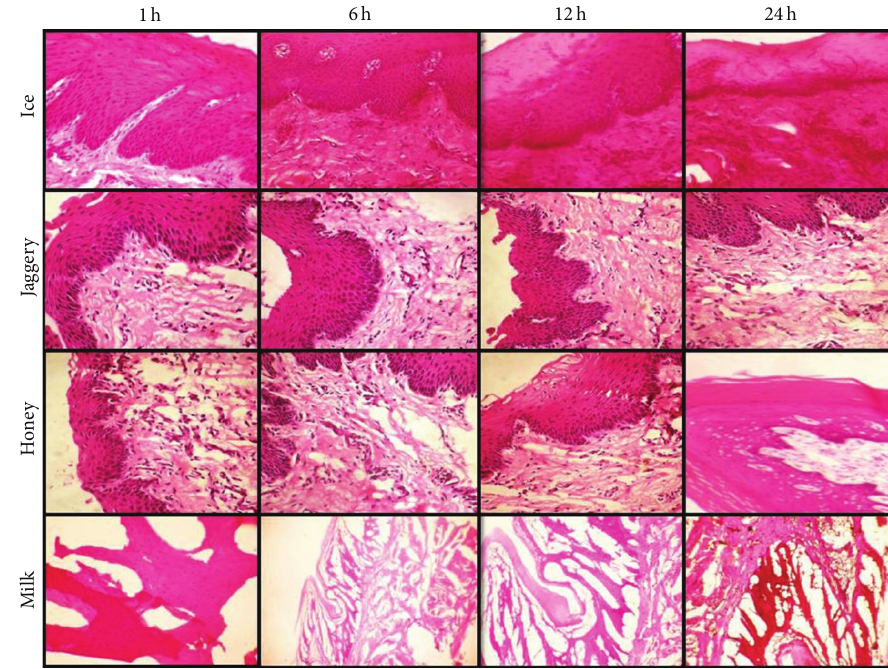
Figure 2: Photomicrograph of the tissues fixed in ice, 30% jaggery, 20% honey, and milk for 1hr, 6hrs, 12 hrs, and 24 hrs, respectively (H&E,